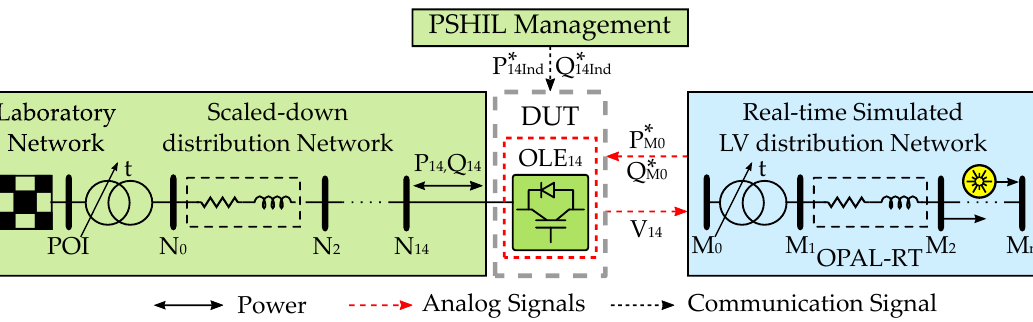
Figure 8. PSHIL application example. Integration of the LV real-time simulated network and the physical MV